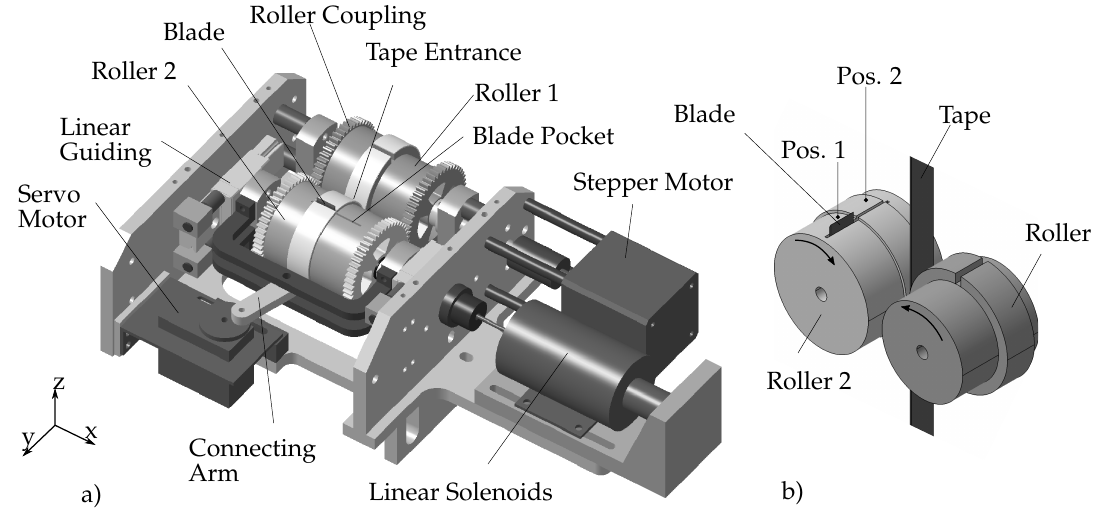
Figure 5. Schematic design of an integrated feeding and cutting unit for an AFP